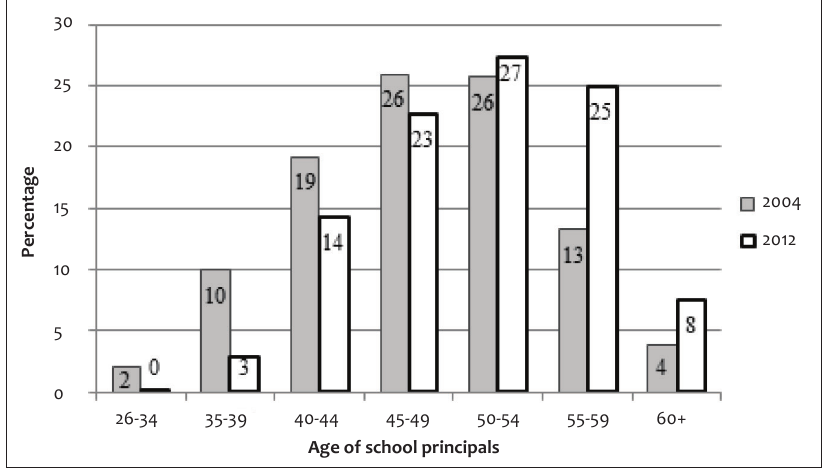
Figure 1: Age distribution of South African school principals in 2004 and 2012 Source: Persal-EMIS matched dataset. Notes: Calculations are based on a sample of principals in Persal that could be matched to a school and are identified as the clear institutional leader of the school. See Table 1.